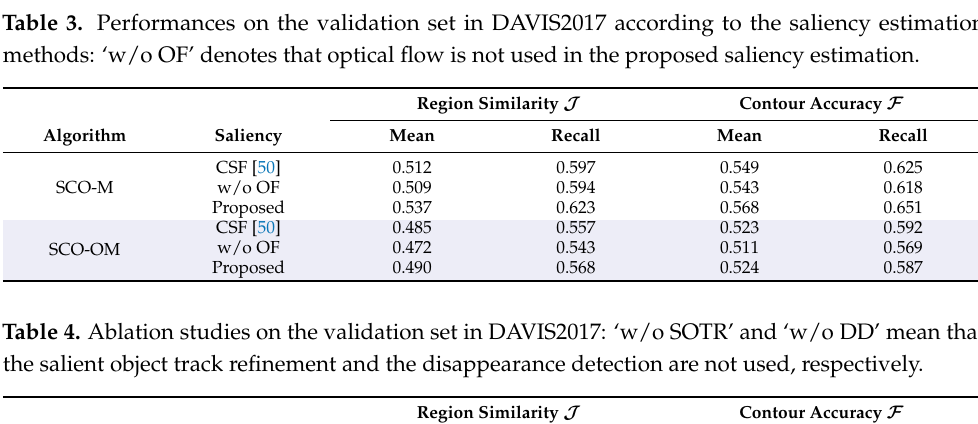
Table 3. Performances on the validation set in DAVIS2017 according to the saliency estimation methods: ‘w/o OF’ denotes that optical flow is not used in the proposed saliency estimation.